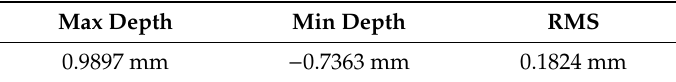
Table 11. The analysis result of the repaired practical rail.